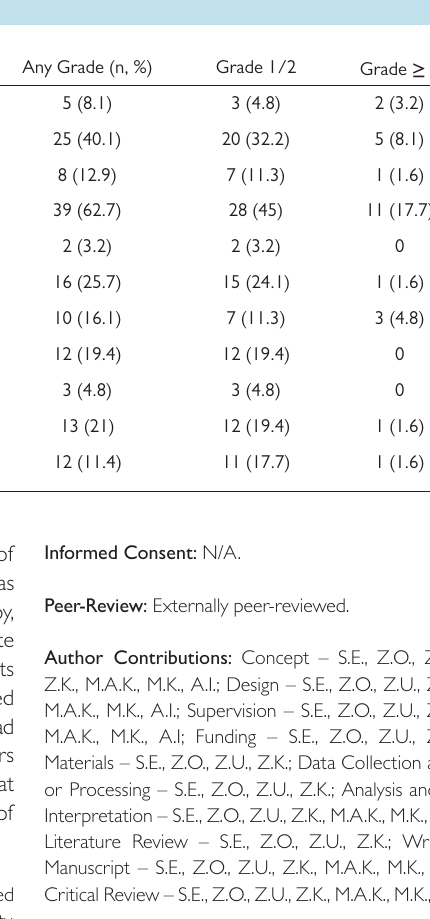
Table 3. Adverse Events Due to